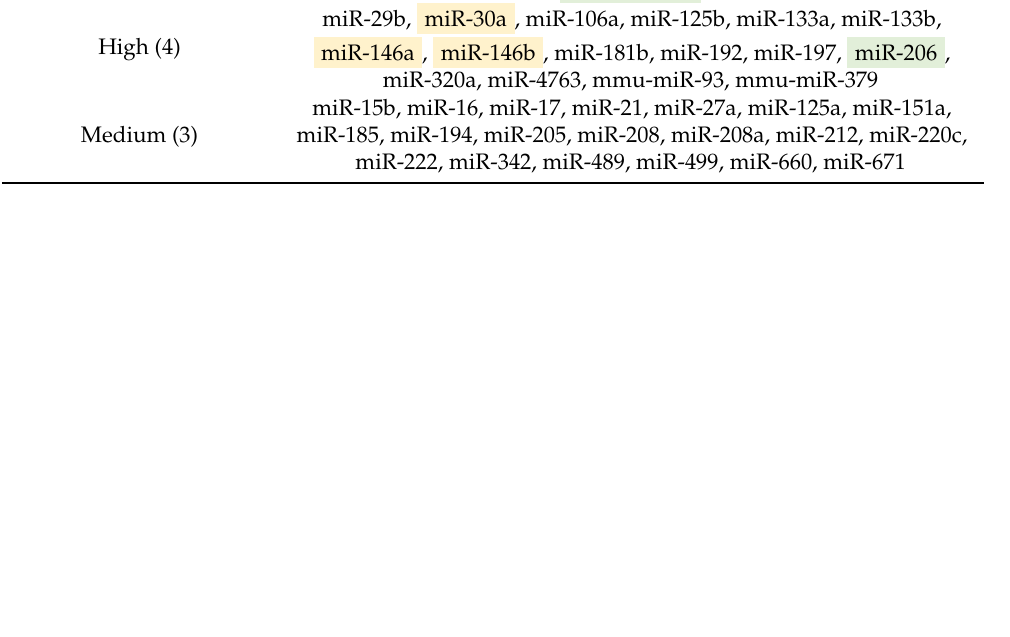
Table 5. Results of